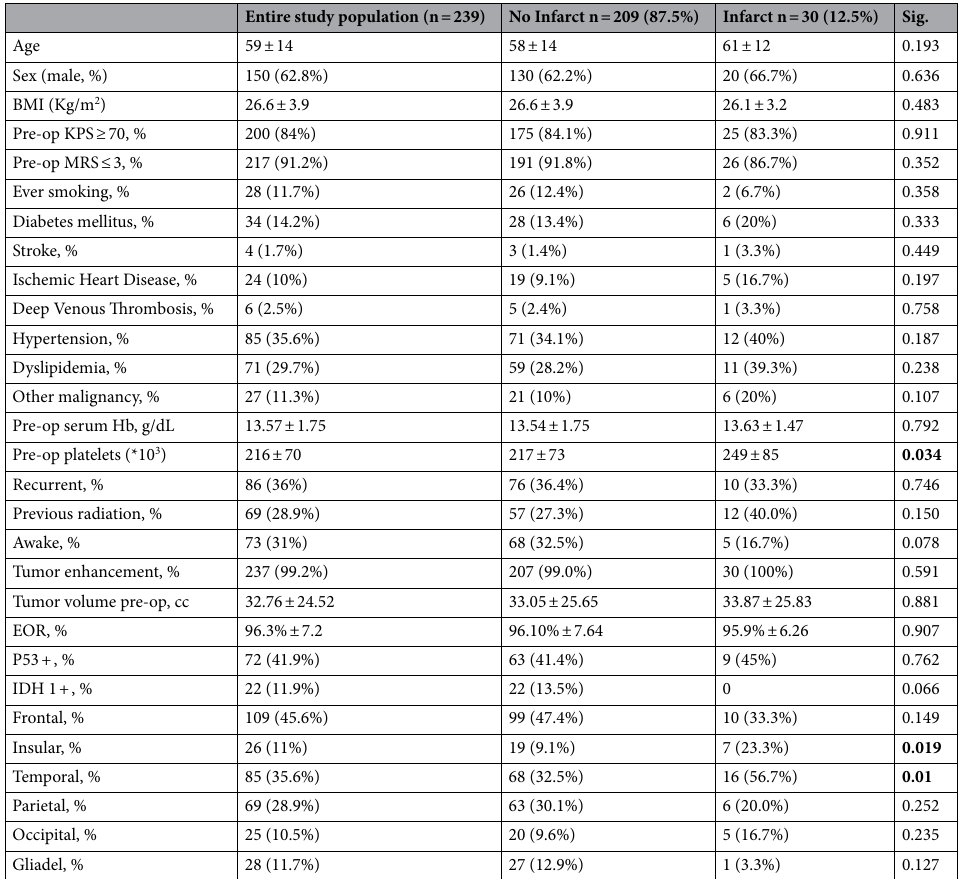
Table 1. Clinical and demographic data of the entire study population, including comparisons between patients with and without intra-operative strokes. Significant values are in bold. * BMI body mass index, KPS Karnofsky performance status, MRS modified rankin scale, Hb hemoglobin, EOR extent of resection, IDH isocitrate dehydrogenase